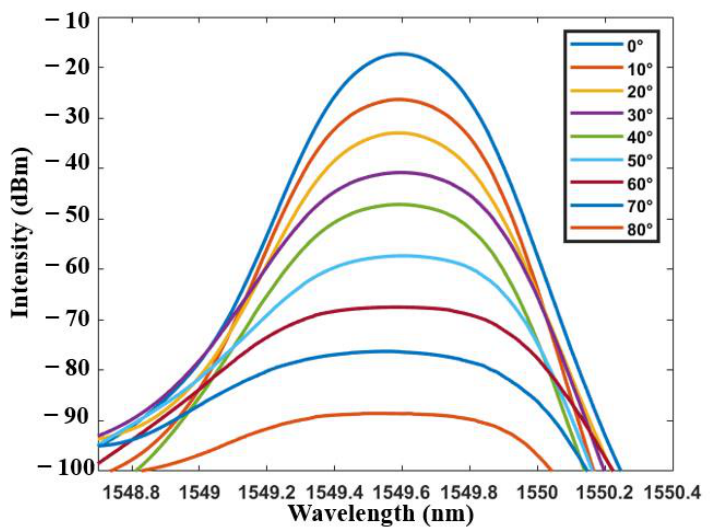
Figure 9. The dependence of the reflection spectrum at the wavelength of the reflection peak at different inclination angles in FRL with waist equals 86 µm.